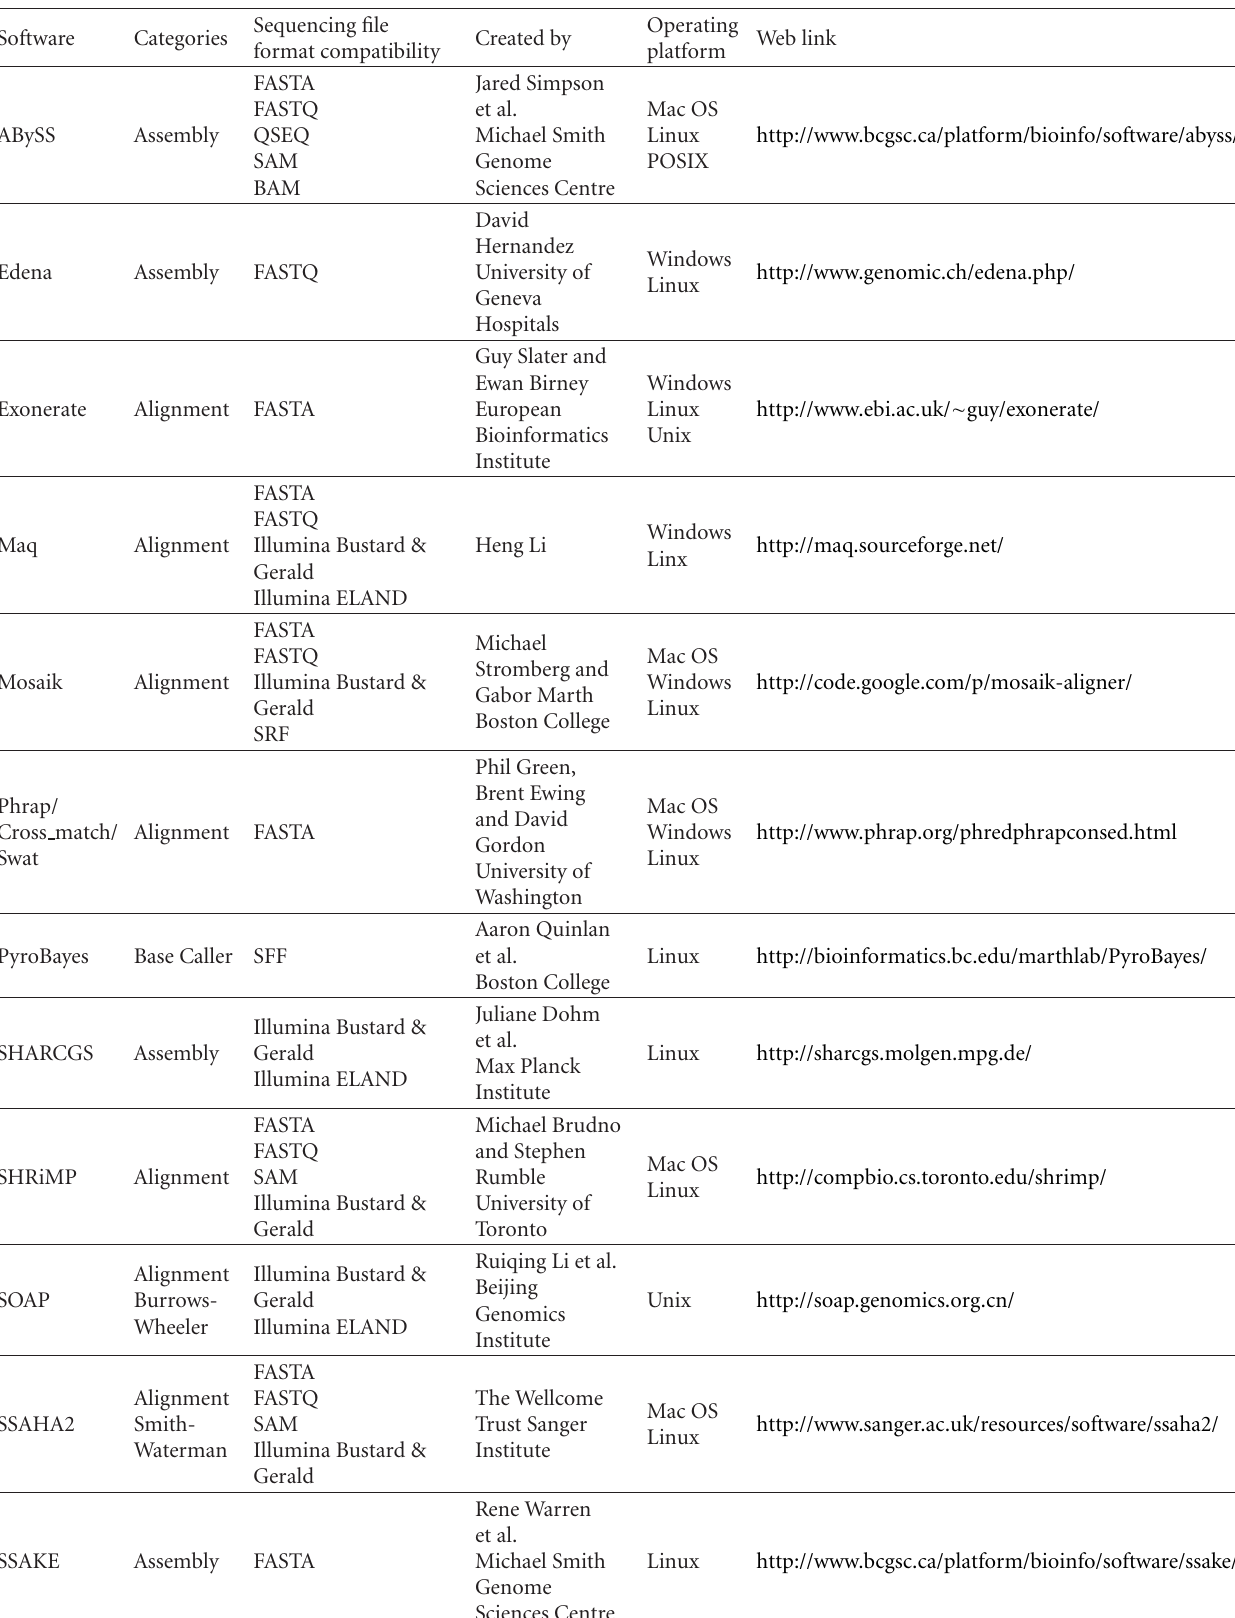
Table 3: Software applications for NGS